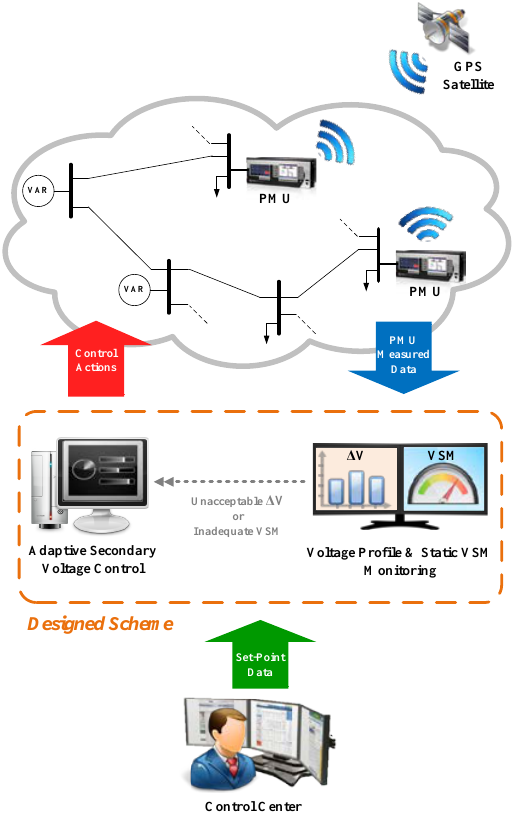
Figure 1. Schematic view of the proposed scheme.